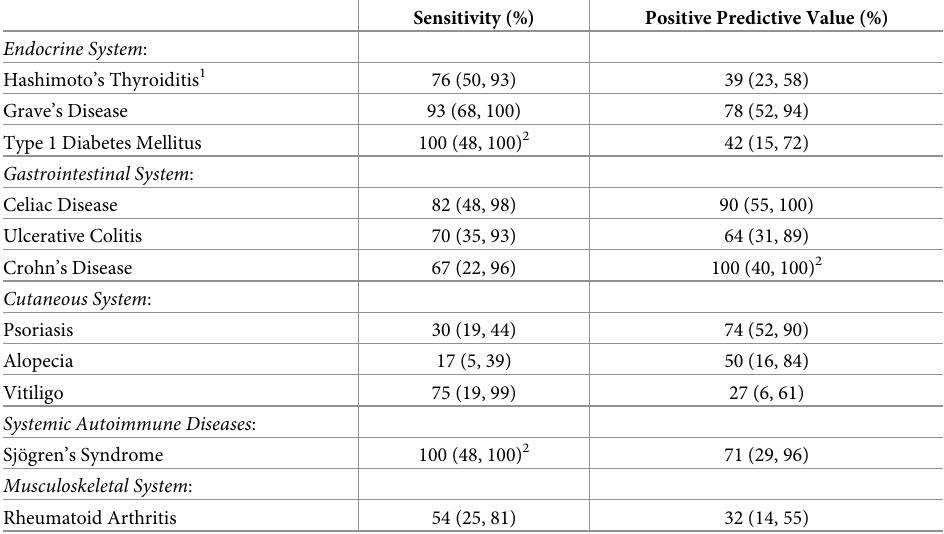
Table 3. Estimated sensitivity and positive predictive value (95% confidence interval) for autoimmune diseases with minimum 0.5% prevalence by self-report or medical record